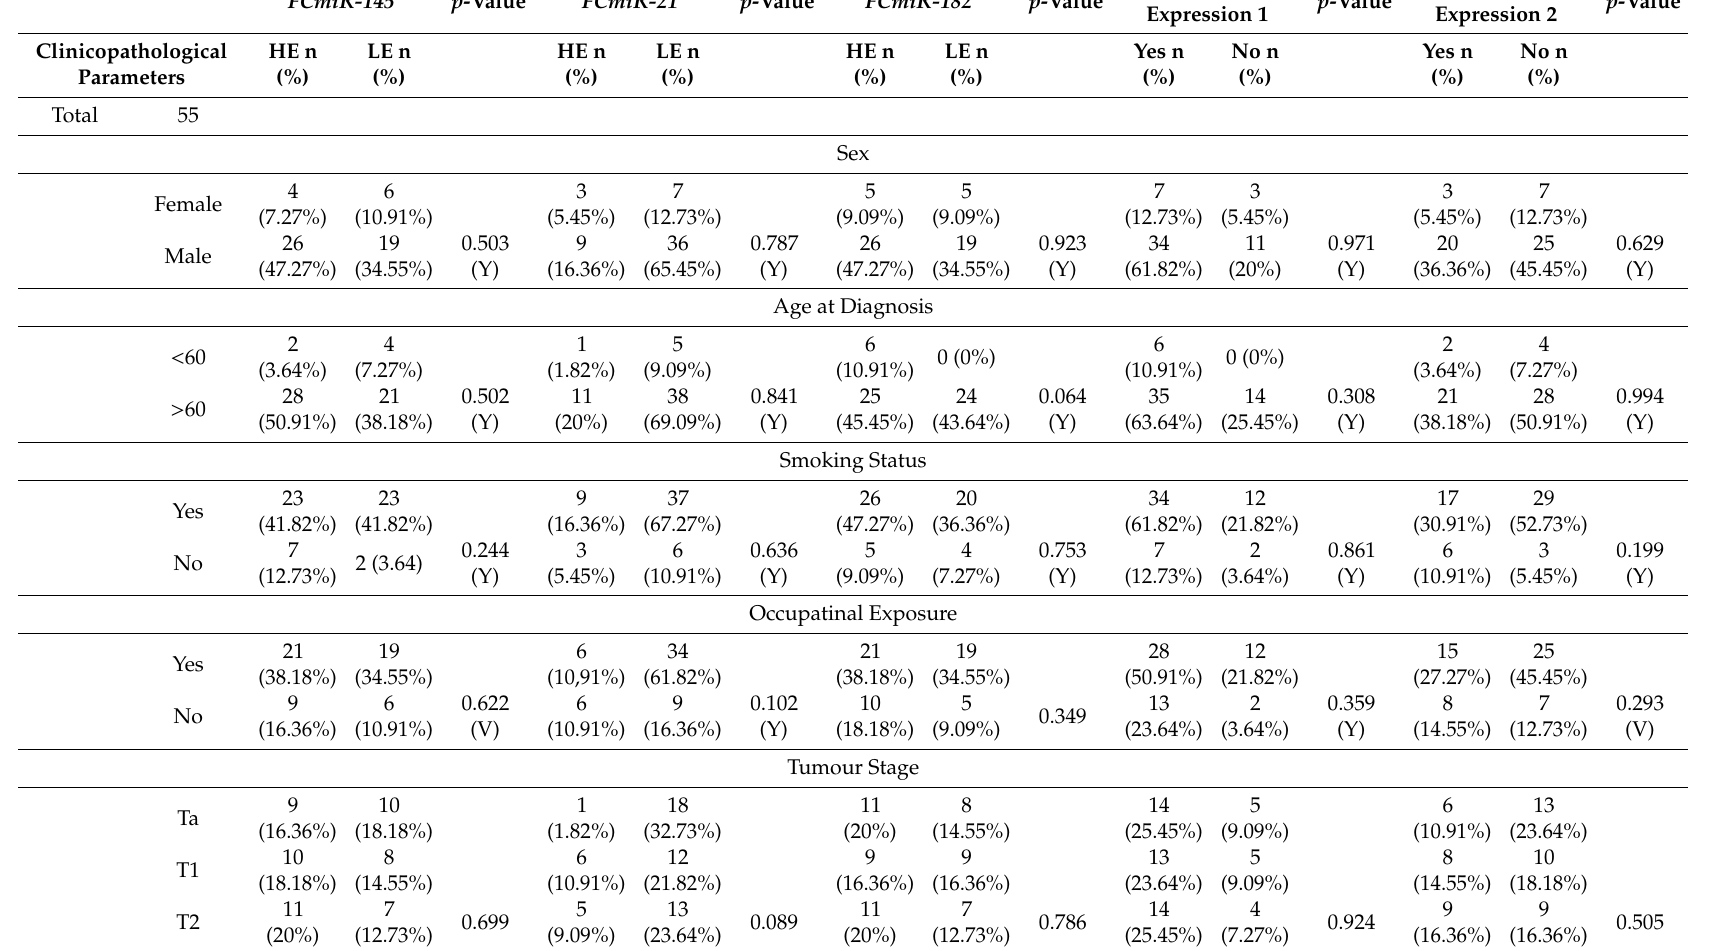
Abnormal Abnormal p -Value p -Value Expression 1 Expression 2